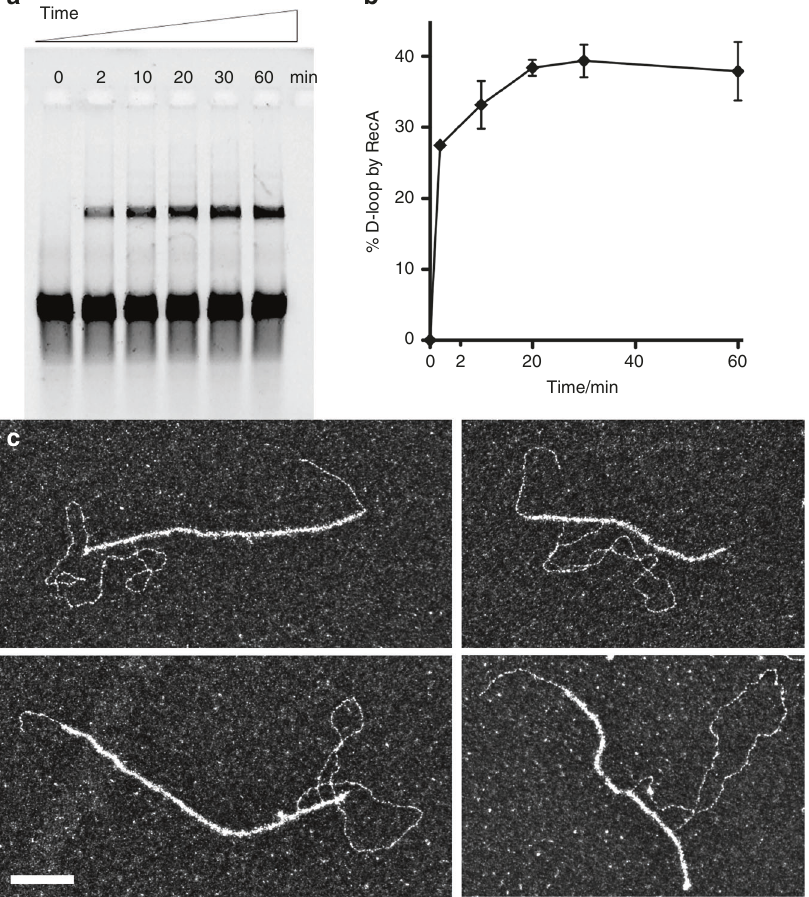
Fig. 4 RecA promotes heteroduplex DNA formation within the nucleoprotein fi lament without dissociating. a Time course of RecA D-loop assay. b Quanti fi cation of RecA time time courses; n = 3, error bars represent standard deviations. c Representative EM pictures of RecA-mediated joint molecules at 20 min. White bar represents 100 nm. Source data are provided as a Source Data fi